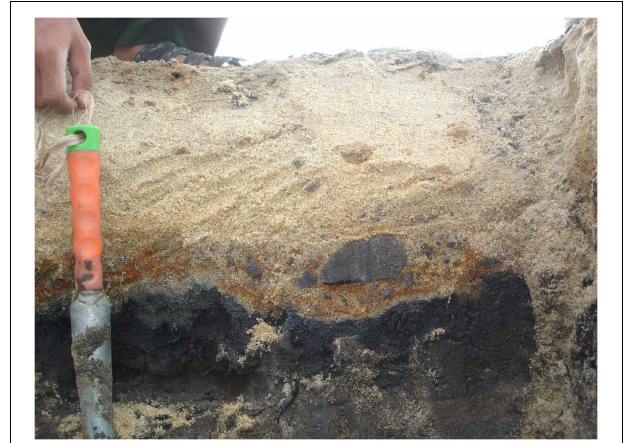
FIGURE 8 | Contact paleo-soil 2 and 2004 IOT deposit showing rip-up clasts